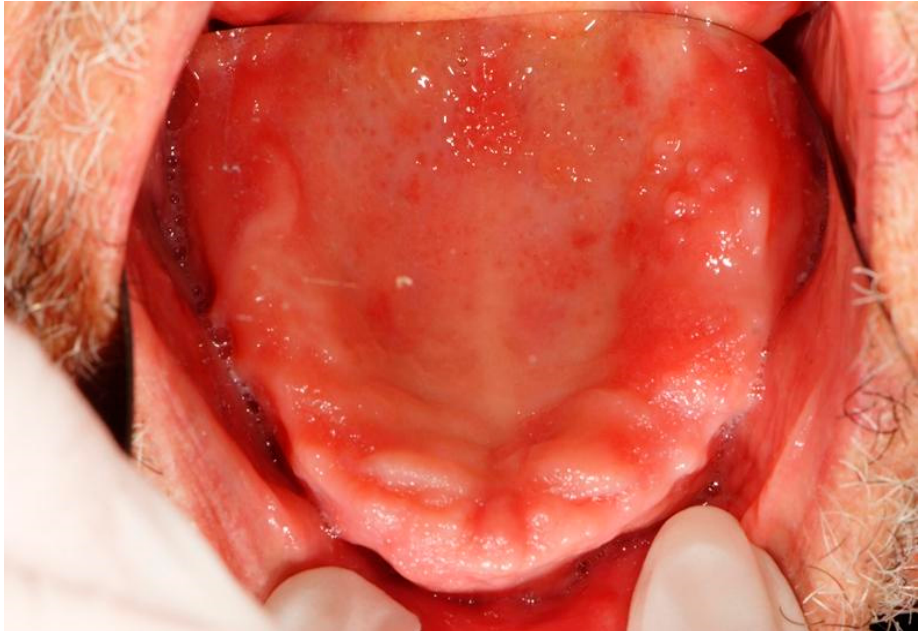
Figure 4. Mucosal erythema, palate (Patient no. 2, Table 2).